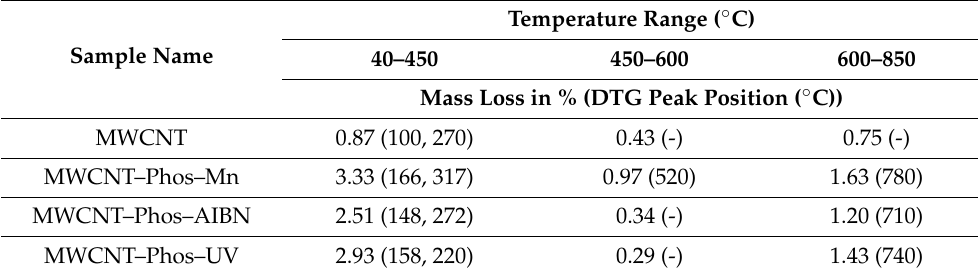
Table 3. Comparison of the mass loss and differential thermal analysis of studied samples.